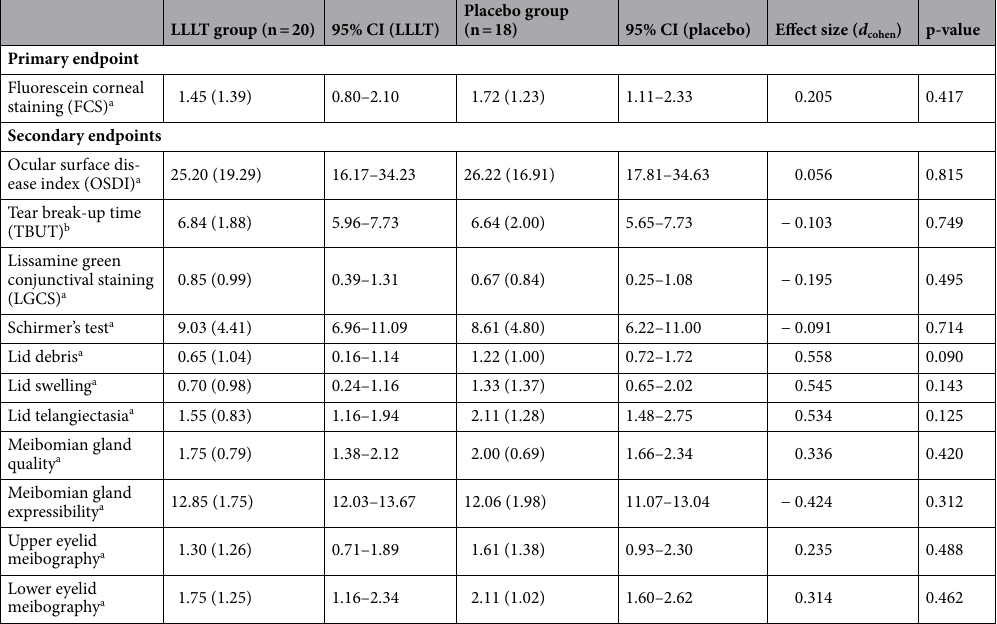
Table 3. Per-protocol analysis for the primary and secondary endpoints after LLLT interventions. a Wilcoxon rank sum test results. b Independent sample